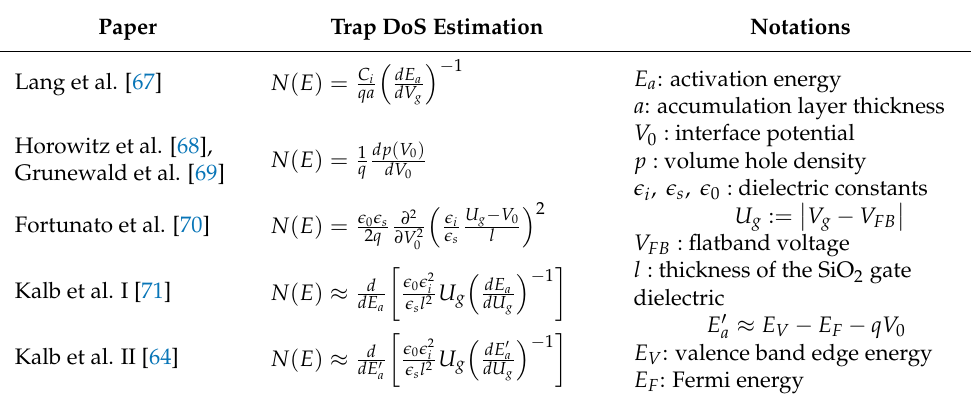
Table 3. Summary of trap DoS approaches [64].